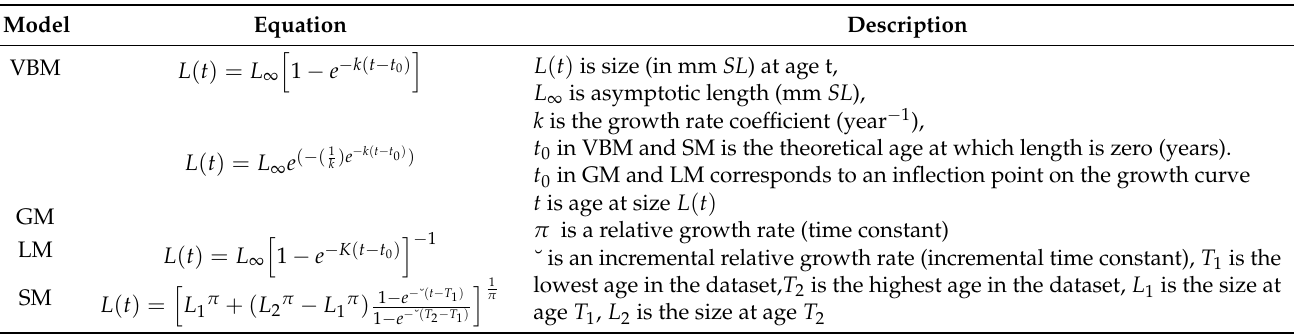
Table 1. Candidate growth models for the temperate Sardinops sagax stock age-at-length data in the southern California Current System